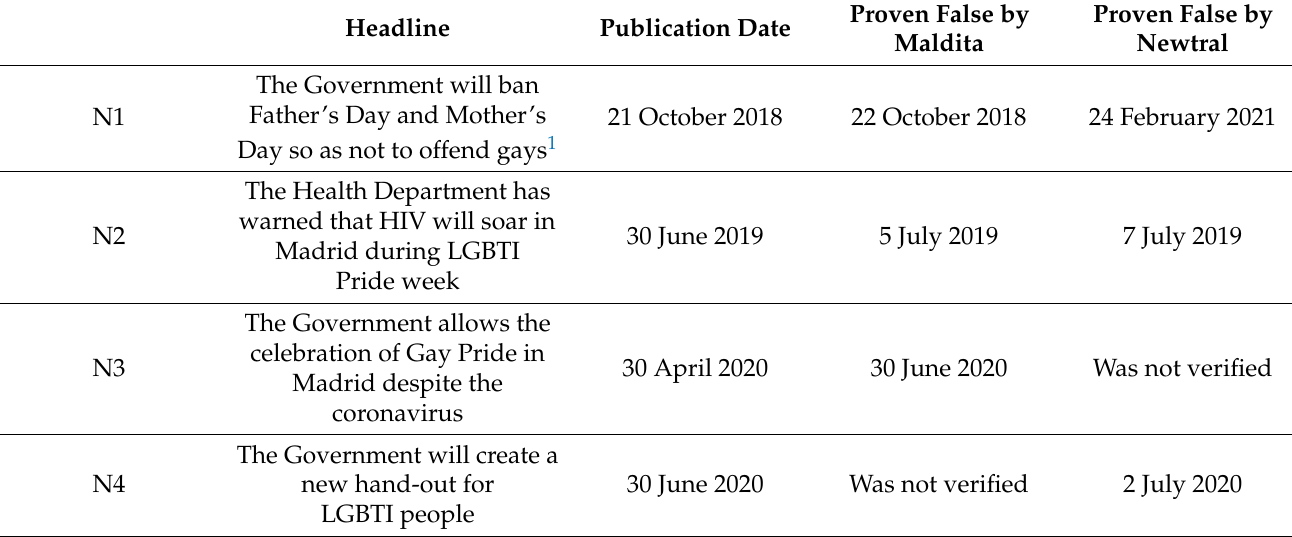
Table 1. Pseudo-news published by Mediterr á neo Digital object of